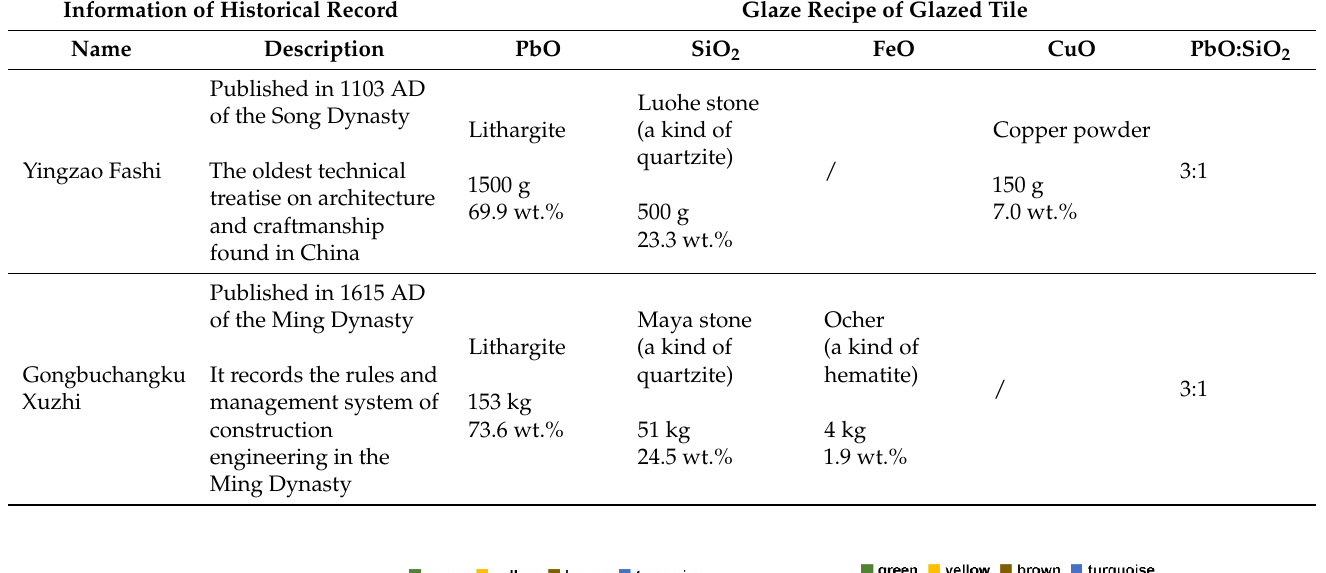
coloring agent. Copper ions can appear peacock blue or peacock green in color in alkaline oxide flux. Table 5. The glaze formula of glazed tile production in historical records.